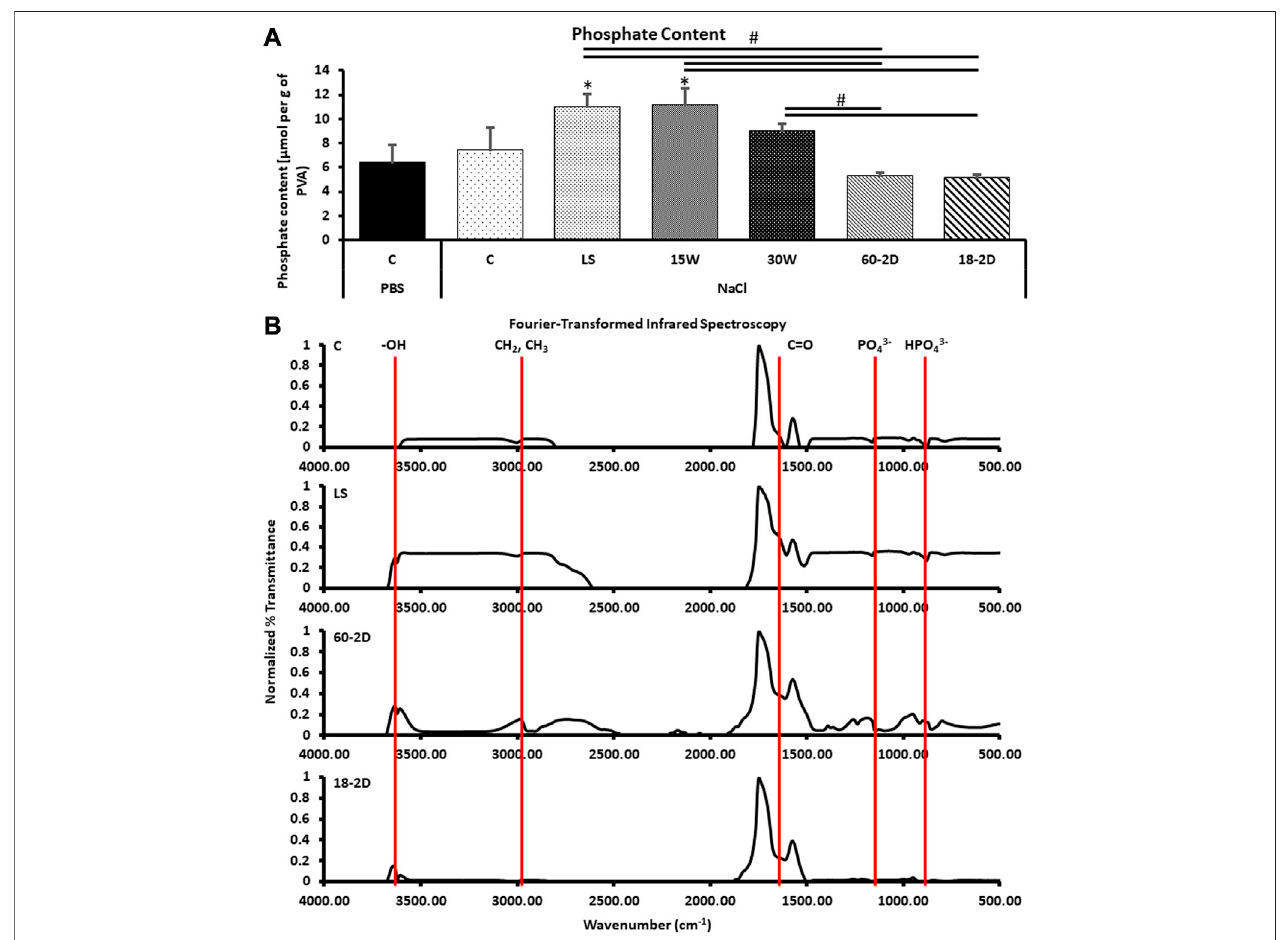
FIGURE 5 | Functional groups and STMP crosslinking density in PVA fi lms. (A) Quanti fi cation of phosphate content for the samples to characterize covalent crosslinking by STMP. *Indicates p ＜ 0.05 between the indicated groups. n (cid:2) 6 for all groups. C PBS was control sample rehydrated in NaCl solution. *Indicates p ＜ 0.05 with respect to the control groups. #Indicates p ＜ 0.05 between the groups being compared. (B) Fourier-transform infrared spectroscopy data. Data was normalized to PVA fi lms. n (cid:2) 3 for all samples.